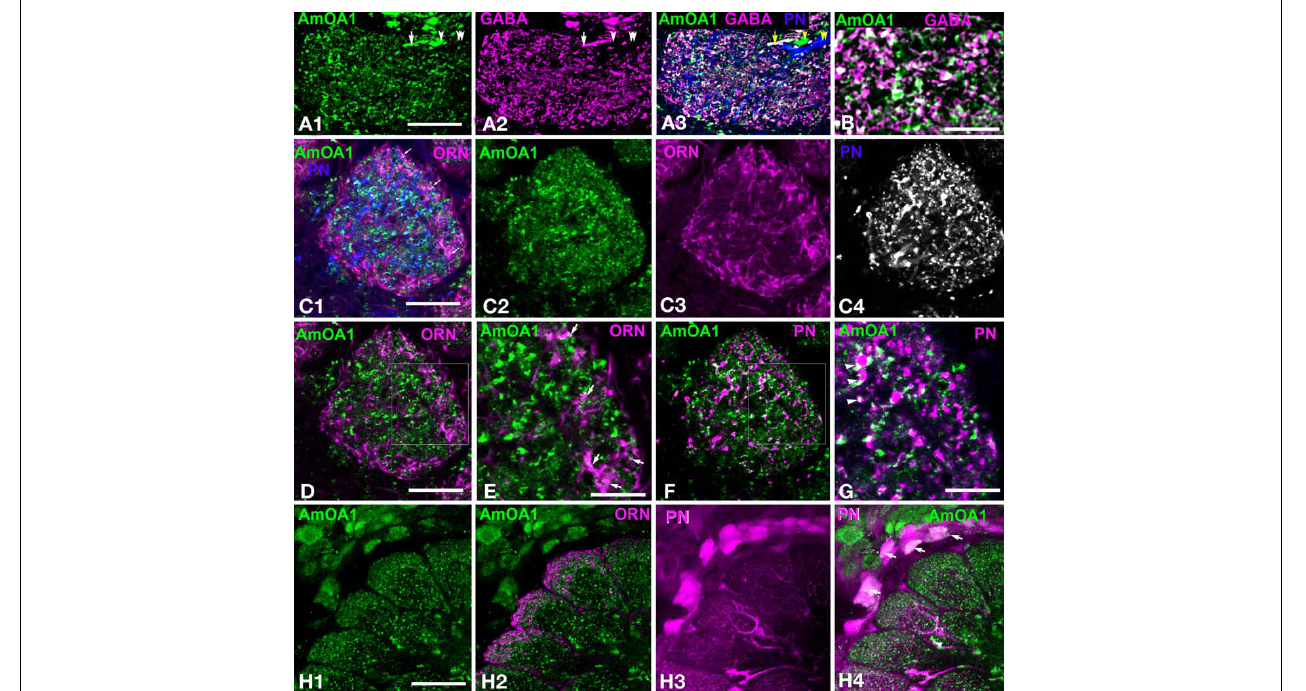
FIGURE 3 | Apis mellifera : The GABAergic processes in glomeruli express AmOA1 (A) Triple labeling of the anti-AmOA1 (green A1) and anti–GABA (magenta A2) in a glomerulus with neurobiotin-injected uPNs (blue A3). (A3) The fibers that enter into the glomerulus are GABAergic co-stained with AmOA1 (white, arrow), non-GABAergic processes co-stained with AmOA1 (green, arrowhead) and uPNs that do not co-localize with AmOA1 (blue, double arrowheads). (B) GABA and AmOA1 staining at higher magnification (C) Triple labeling of a glomerulus (C1) in which anti-AmOA1 (green, C1 and C2 single image) and ORNs were labeled by anterograde staining with Rhodamine-dextran (magenta C1 , single image C3 ), and uPNs are shown by retrograde staining (blue C1 , and black and white in a single image C4 ). (D) The same glomerulus as in (C1) but only ORNs (magenta) and AmOA1(green) are shown (E) illustrates a high